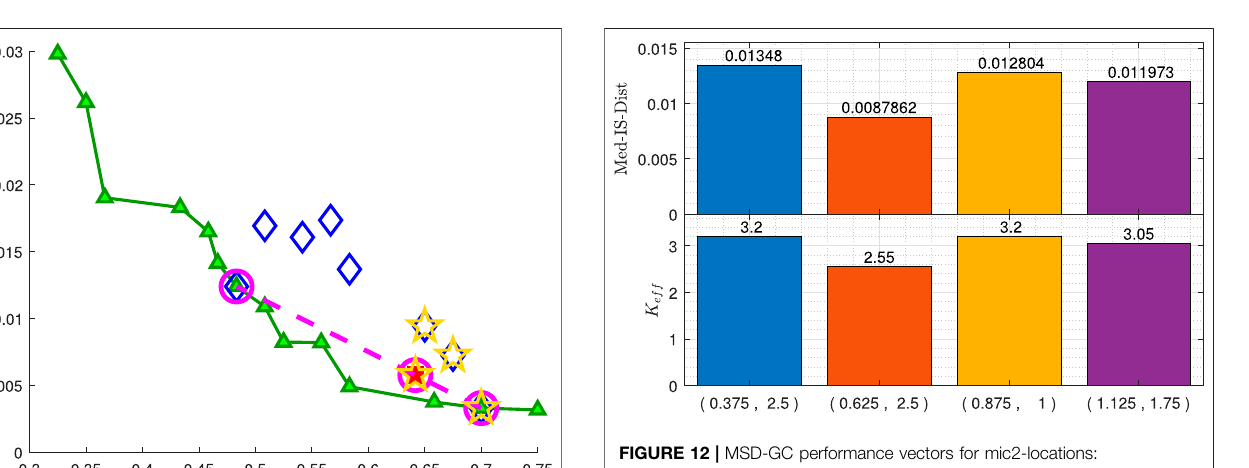
FIGURE 12 | MSD-GC performance vectors for mic2-locations: [ 0 . 375 , 2 . 5 ] (mic1 ’ s location), [ 0 . 625 , 2 . 5 ] , [ 0 . 875 , 1 ] , and [ 1 . 125 , 1 . 75 ] , under the scenario of K = 6 and